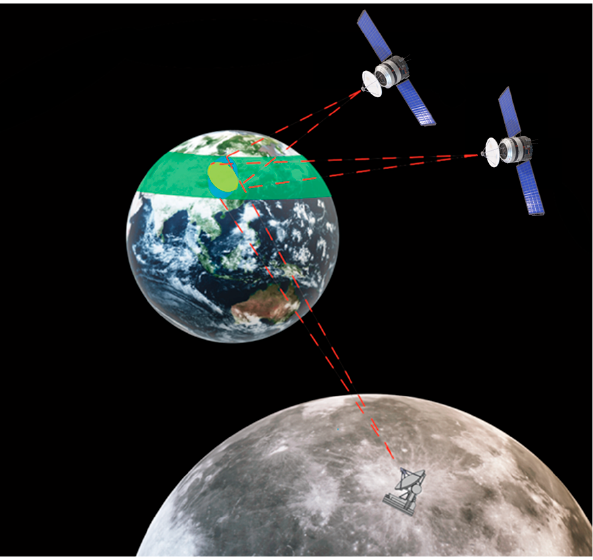
Figure 1. A conceptual illustration of MS-BiSAR Earth observation.